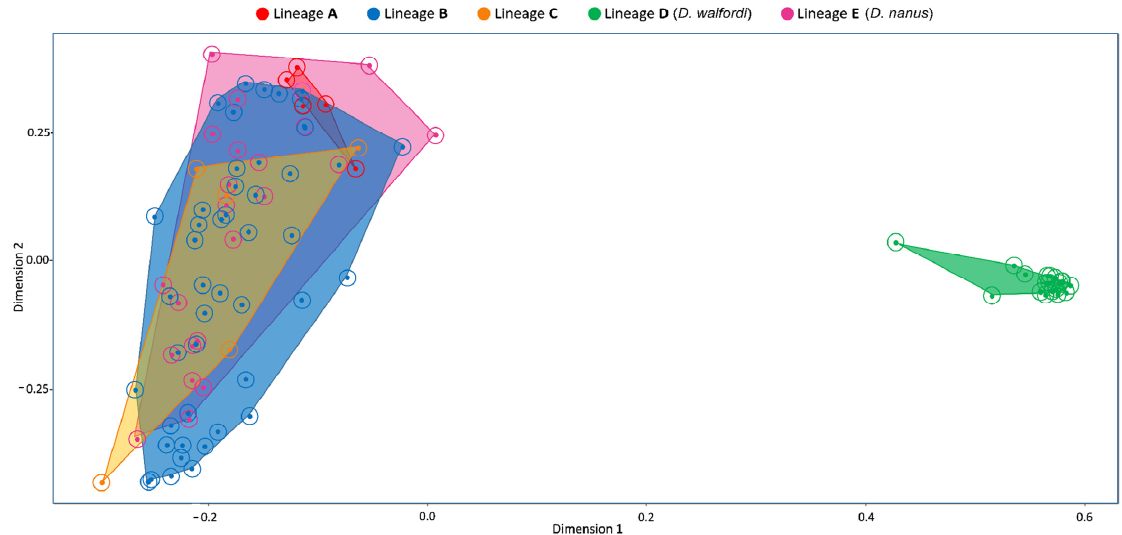
Figure 3. Multidimensional scale scatter of random forest results on acoustic variables. Plots of the first two axes of a multidimensional scale analysis of the acoustic data of Lineages A–E of the D. nanus–D. walfordi species complex. Topotypes of D. walfordi are included in Lineage D (green), and topotypes of D. nanus are comprised in Lineage E (pink).